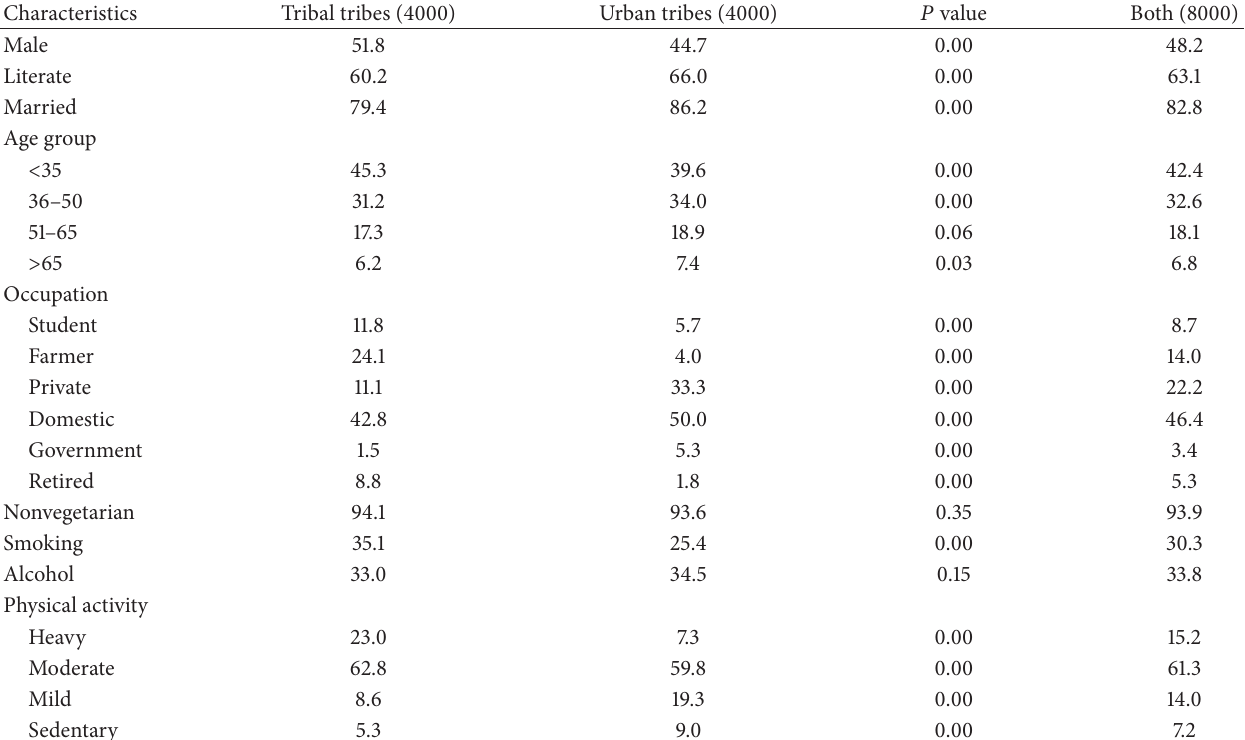
Table 2: Distribution of baseline characteristics among tribes of urban and tribal areas, Himachal Pradesh, 2011-2012.